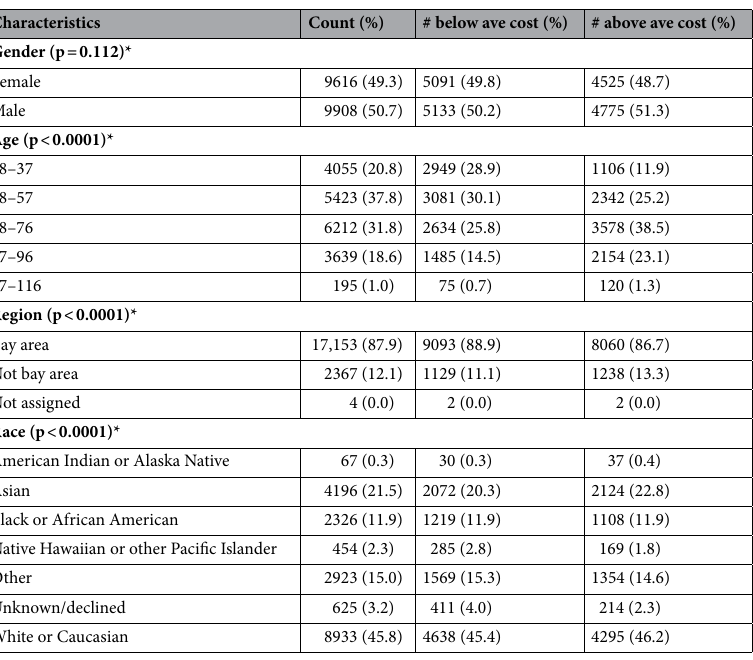
Table 1. Patient demographics for prediction of 1-year expenditure. *p-value is comparing the relationship between cost and the corresponding variables using chi-squared test for independence for categorical variables, two-tails at significance level 0.05.